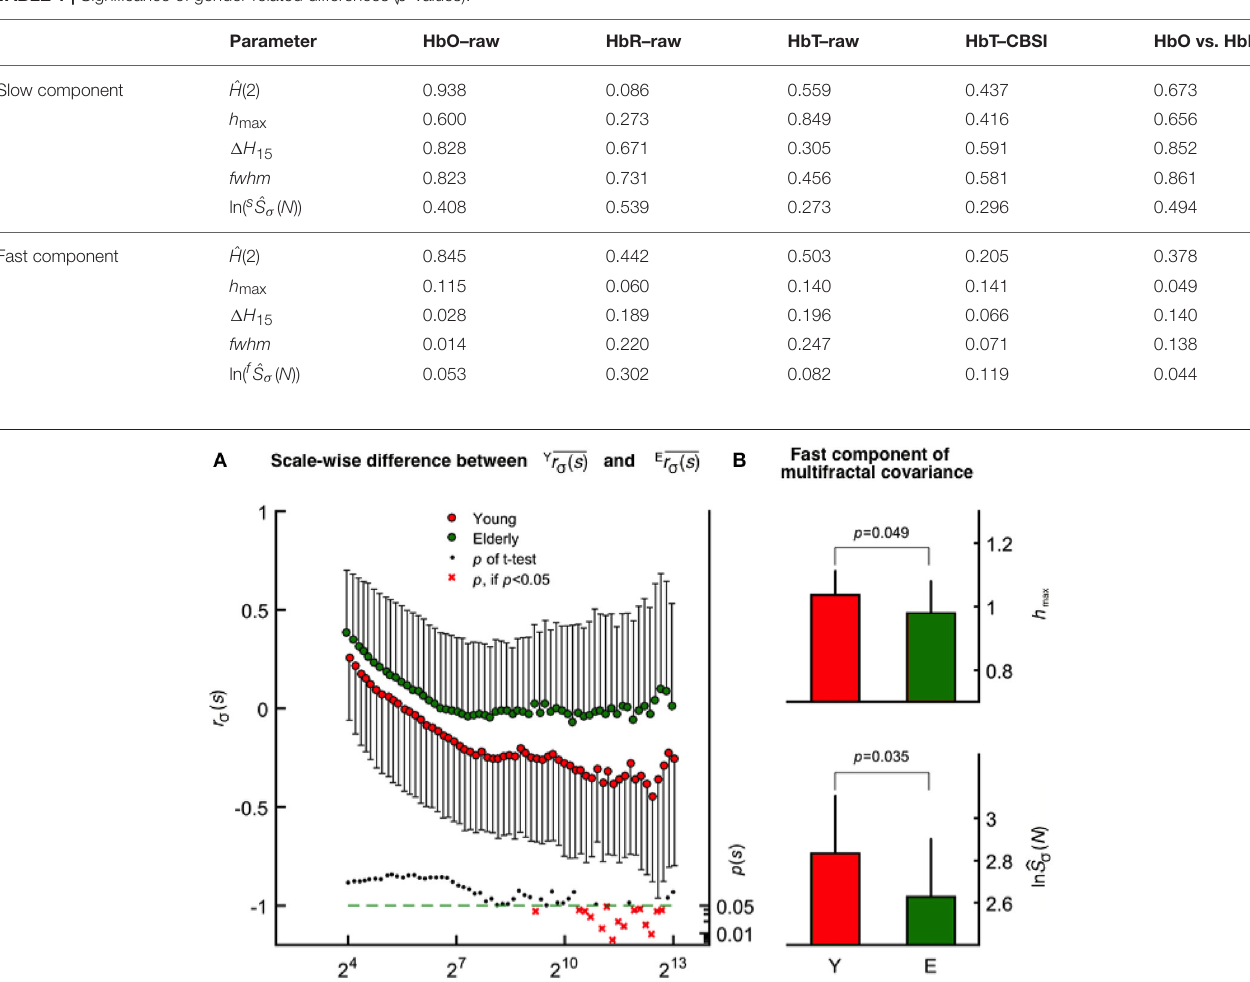
TABLE 1 | Significance of gender-related differences ( p -values).